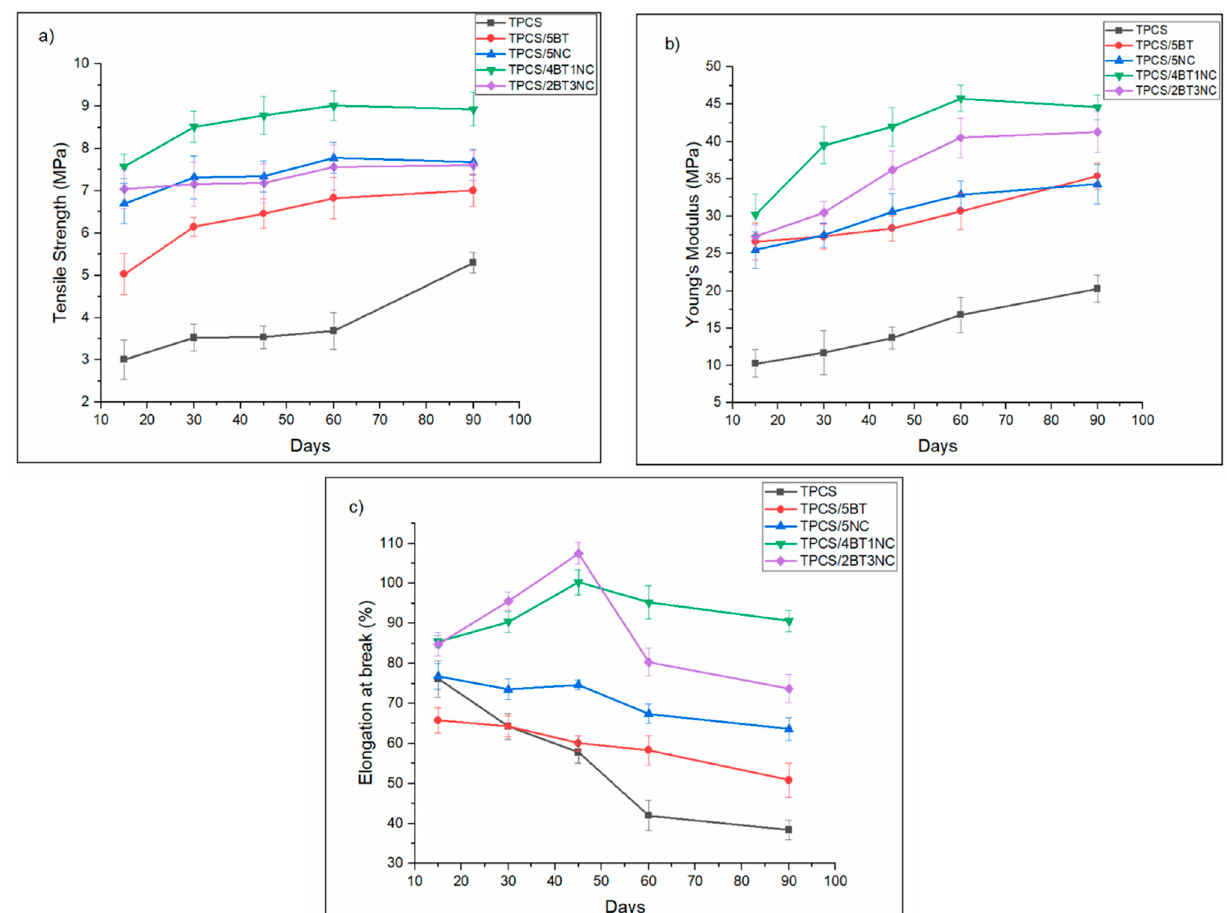
Figure 2. ( a ) Tensile strength, ( b ) Young’s modulus, and ( c ) Elongation at break of TPS, TPSC, and HTPS films aged for 15, 30, 45, 60, and 90 days. HTPS films aged for 15, 30, 45, 60, and 90